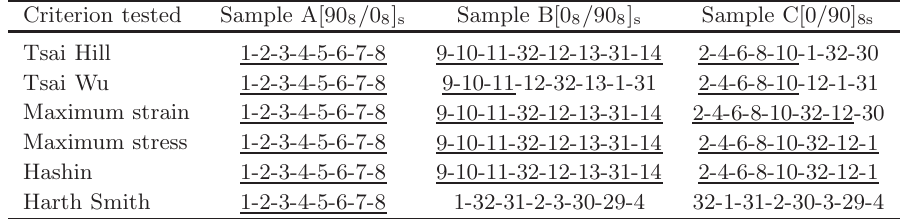
Table 3. Successive failures results of laminates (A, B, C) with the total discount